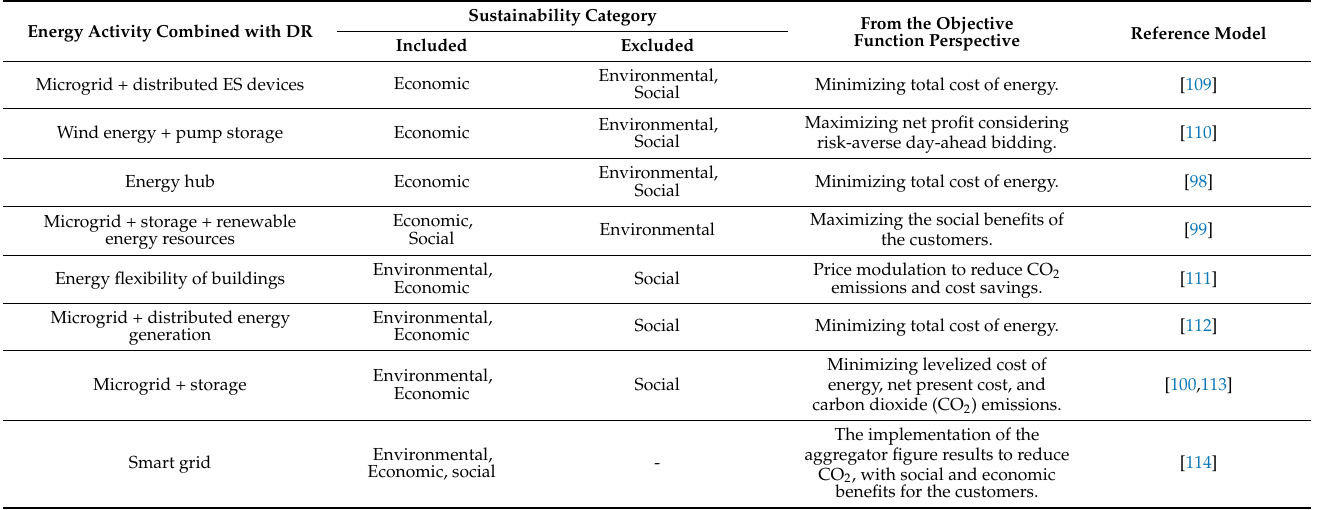
Table 2. Sustainability categories used for assessing demand